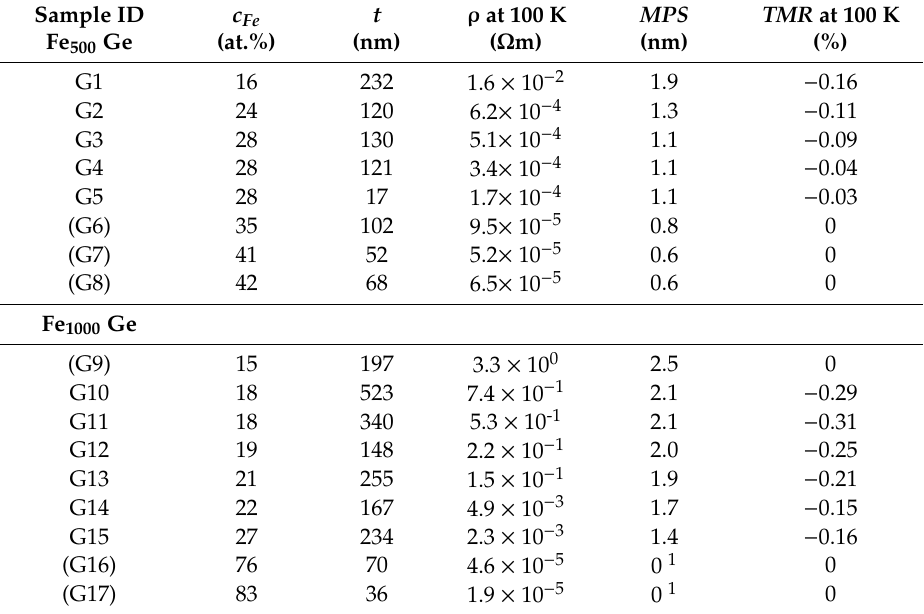
1 Sample is above percolation